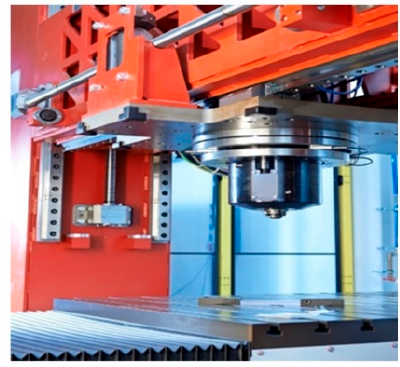
Figure 1. RNA custom equipment. (Photo: Helmholtz-Zentrum Geesthacht/Rasmus Lippels). The user-set process parameters for this force-controlled variant were: rotational speed (RS); friction force (FF); forging force (FoF); friction time (FT); and forging time (FoT). Table 3 presents the joining parameter ranges used. Table 3. Process parameter ranges.